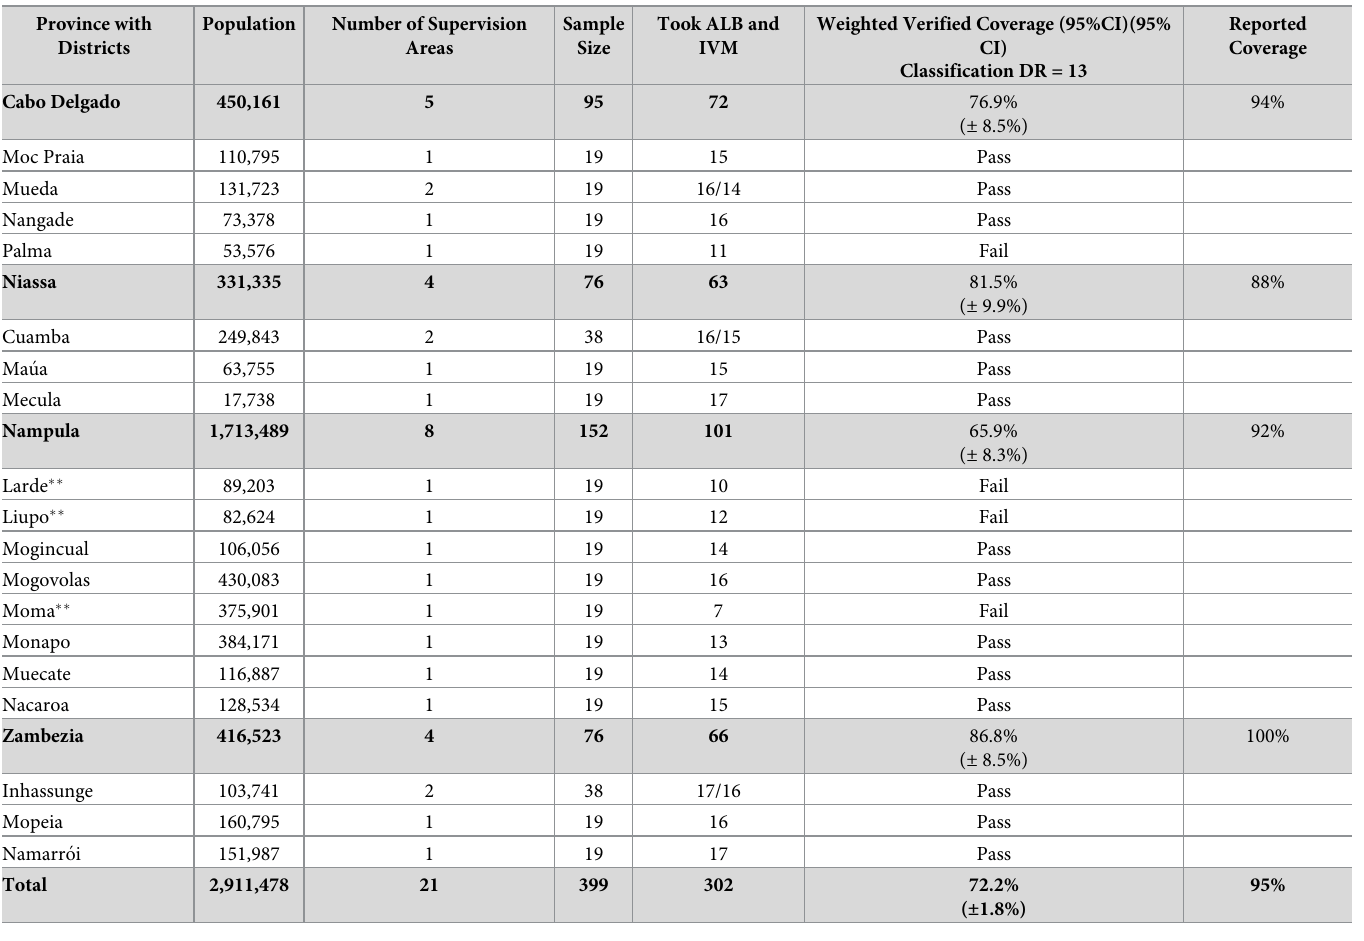
Table 2. Mozambique districts, populations, sample sizes and study results July 2016 � . Province with Districts